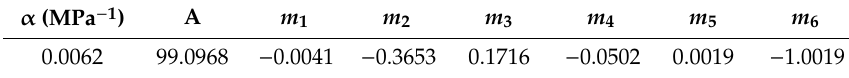
Table 5. The material parameters in the mHS equation.